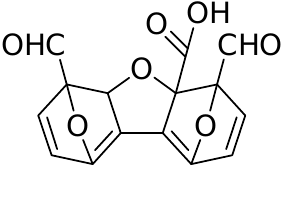
Figure 6. Product of the reaction catalyzed by 30 nm CuO and Ag